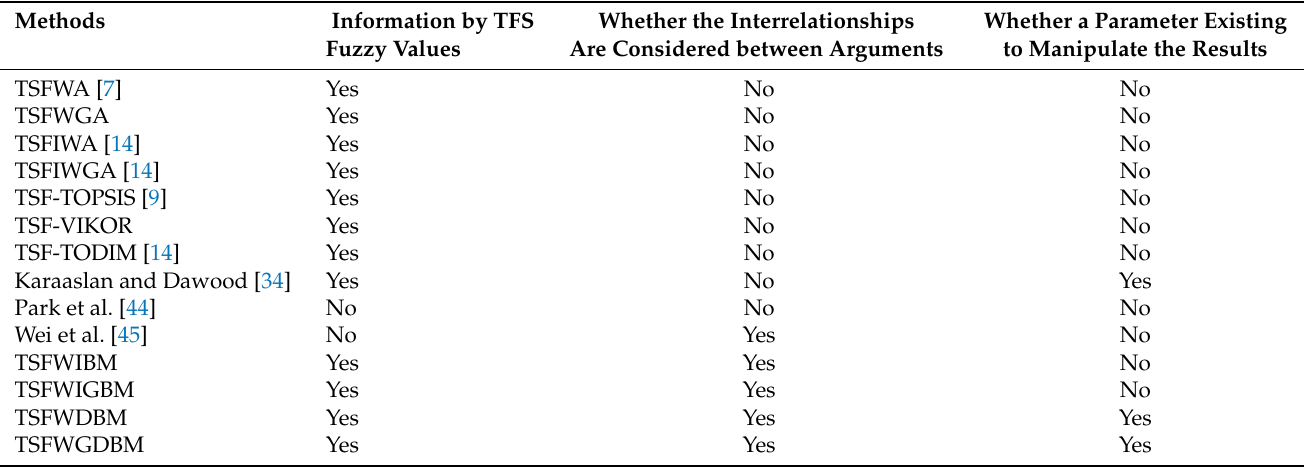
Table 15. Comparison of TSF aggregation method with other